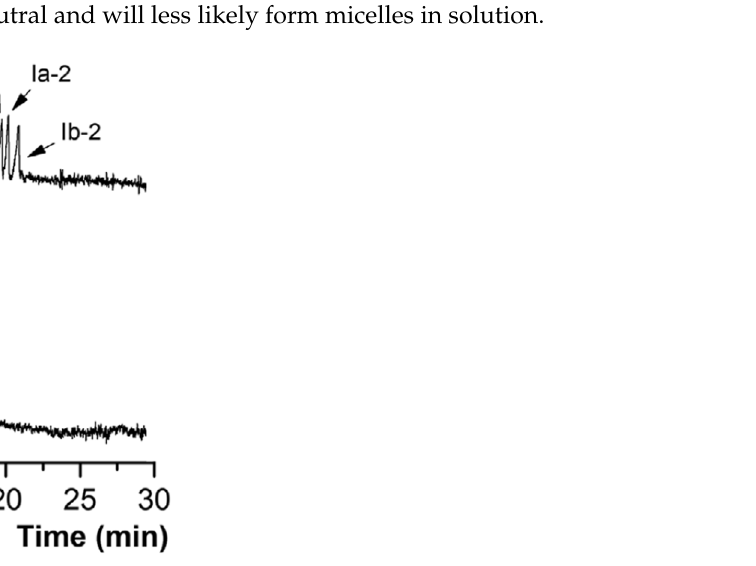
Figure 4. Electrochromatogram of the chiral separation four verteporfin enantiomers. Separation conditions: BGS: 25 mM sodium cholate in 120 mM Tris (pH 7.5) with or without 15% ACN. Sample injection: 0.5 psi for 5 s. Voltage: 15 kV. Detection: 428 nm. Capillary dimension: 50 cm (40 cm effective length) × 75 µm. Modified with permission from the authors [42], © 2021 John Wiley and Sons.